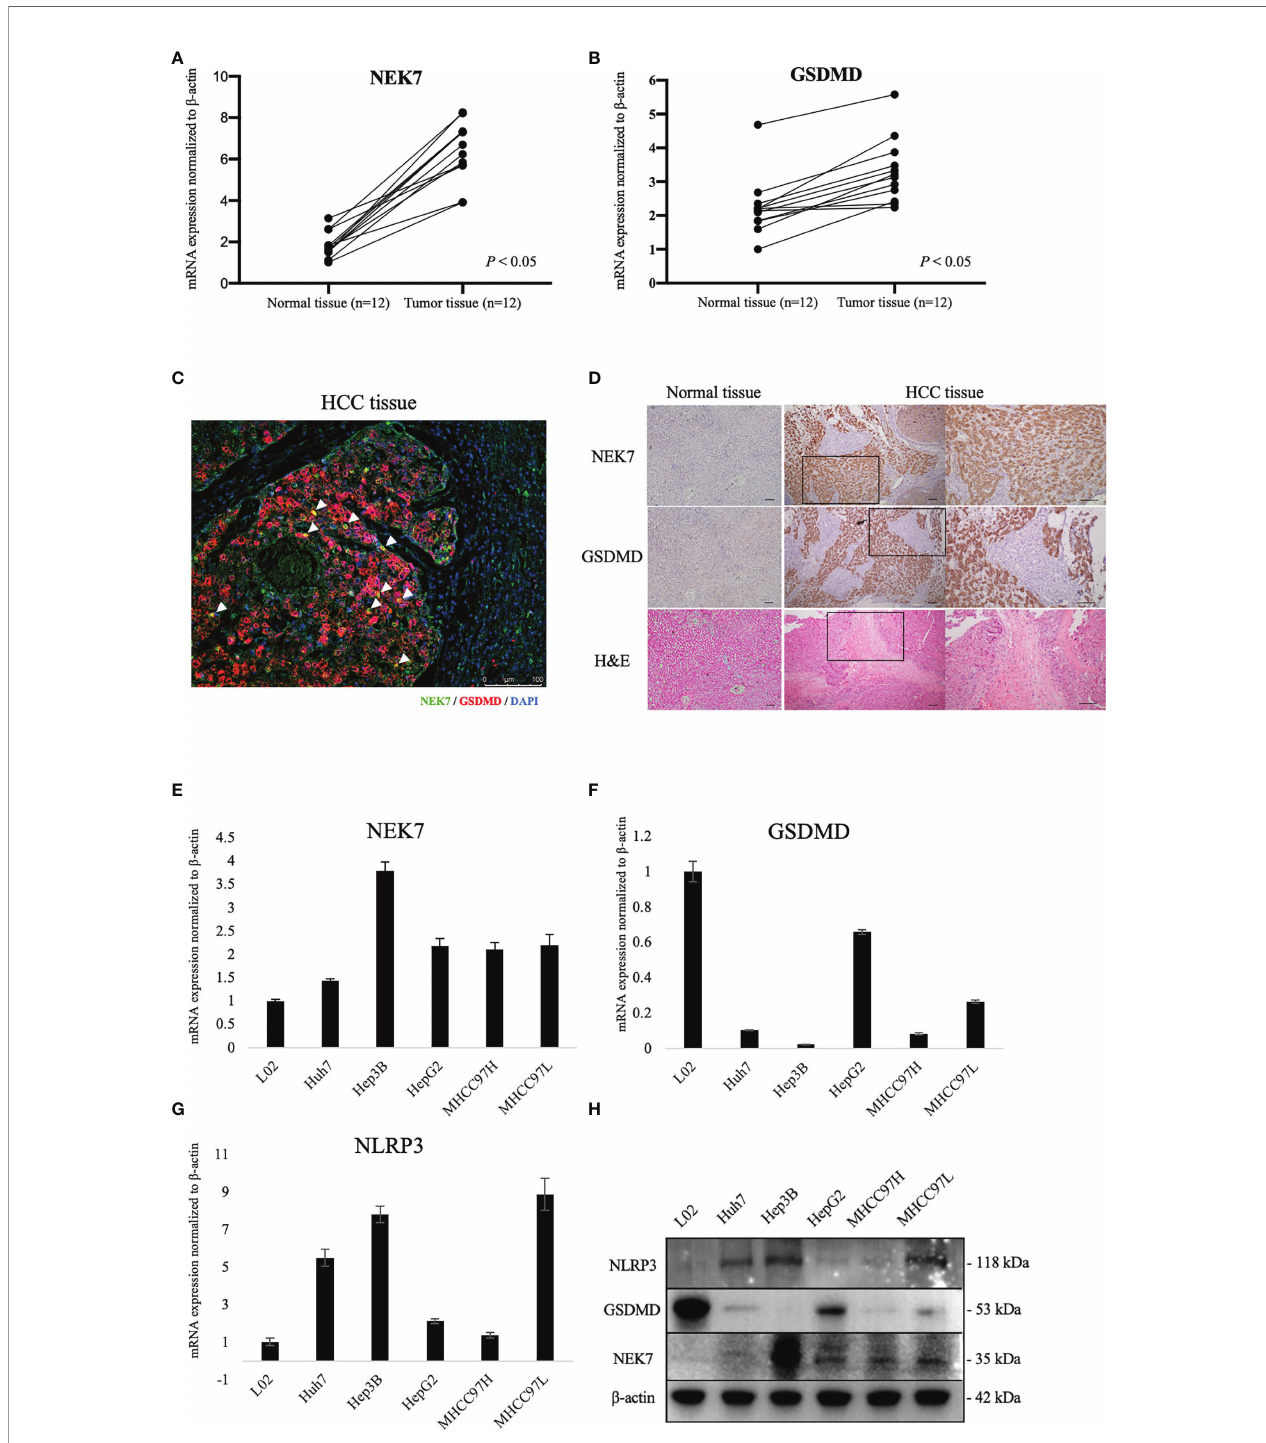
FIGURE 2 | Expression of NEK7 and GSDMD in hepatocellular carcinoma tissues and cell lines. (A, B) mRNA expressions of NEK7 and GSDMD were signi fi cantly upregulated in tumor tissues compared to tumor-adjacent normal tissues. (C) mIHC staining of NEK7 (green) and GSDMD (red) on HCC specimens. Scale bar = 100 m m. (D) Co-locolization between NEK7 and GSDMD was observed on serial sections of HCC specimens. Scale bars = 100 m m. (E) NEK7 mRNA expression in HCC cell lines. (F) GSDMD mRNA expression in HCC cell lines. (G) NLRP3 mRNA expression in HCC cell lines. mRNA expression was normalized by b -actin expression. Error bar, error value in triplicate. (H) Protein expressions of NEK7, GSDMD, and NLRP3 in HCC cell